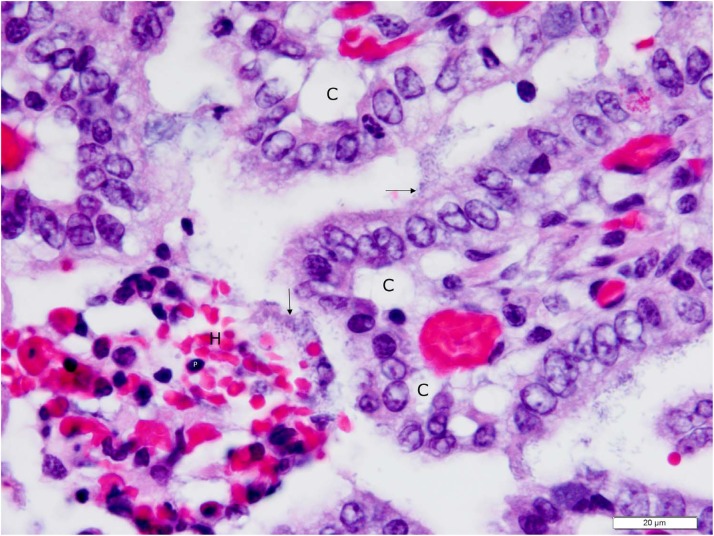
Higher (100X objective) magnification photomicrograph of jejunum shown in Fig. 5 with detail of necrotic and intact villi.The lamina propria of a necrotic villus is hemorrhagic (H), and contains numerous cells with pyknotic nuclei (P), indicating coagulation necrosis. The epithelium overlying this villus is absent, due to necrosis and sloughing of epithelial cells into the intestinal lumen. The exposed basal lamina of the necrotic villus is colonized with enterotoxigenic E. coli (vertical arrow), with bacteria having penetrated into the lamina propria with access to the microcirculation. The villi above and to the right of the necrotic villus have ETEC bacteria (horizontal arrow) colonizing the apical surfaces of absorptive epithelial cells. Many of these epithelial cells are in the process of sloughing as evidenced by the presence of clefts (C) between their basolateral surfaces and the underlying basal lamina. Photomicrograph was taken of 4 μm-thick section of 10% neutral-buffered formalin-fixed, paraffin-embedded jejunal tissue stained with hematoxylin and eosin. Bar = 20 μm.